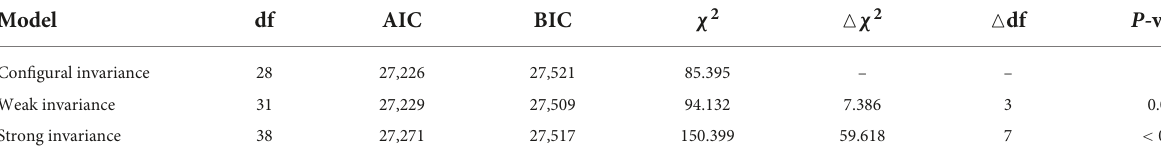
TABLE 3a Comparison of test statistics when establishing configural, weak, and strong measurement invariance across groups. Model